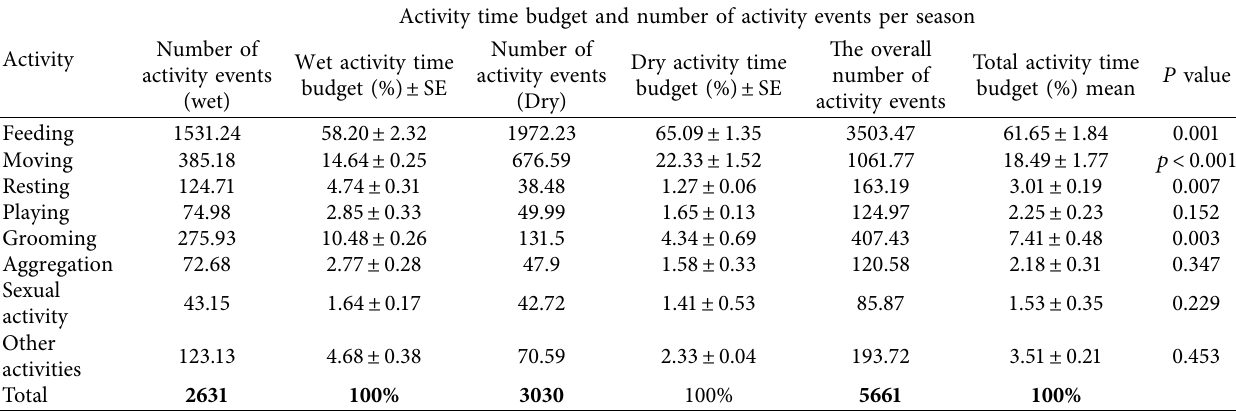
Table 1: Mean activity time budget (%) and a number of activity events of geladas during the wet and dry seasons in Kotu forest, Ethiopia.